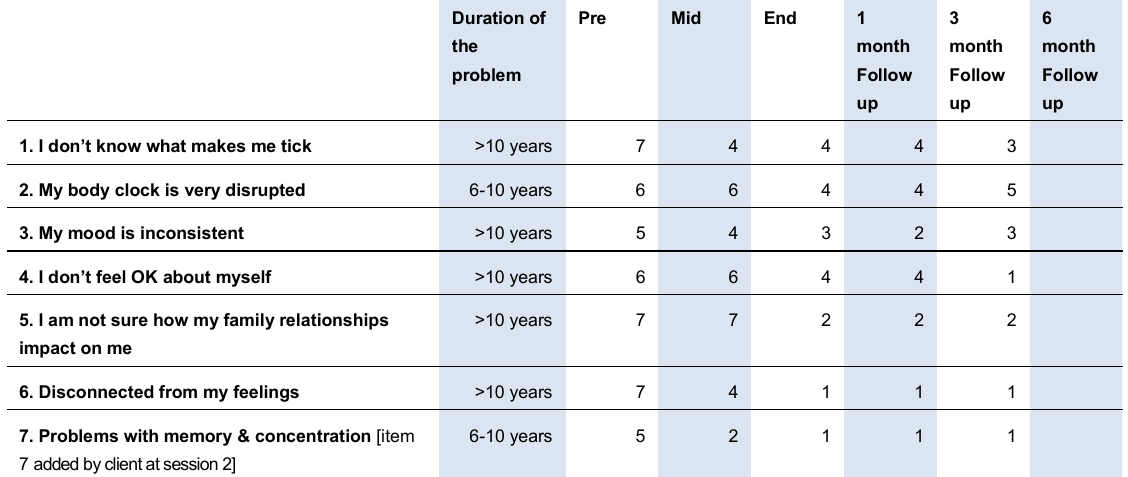
Duration of the problem